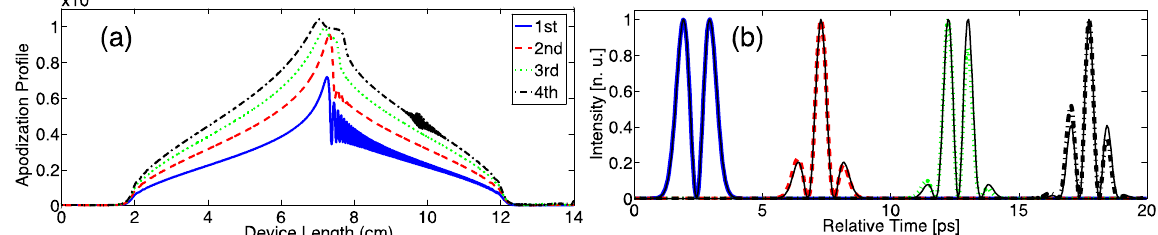
Figure 9. ( a ) Apodization profiles of the gratings required to implement Nth-order (up to N = 4) optical differentiators based on FBGs in transmission considering realistic spatial resolution (0.5 mm); ( b ) Intensity outputs from the obtained FBG devices.